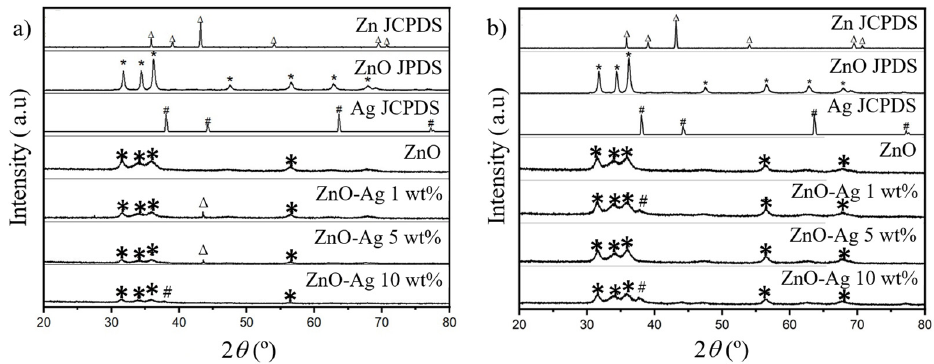
Figure 4. Crystalline phase of ZnO and ZnO ‐ Ag fabricated at a carrier gas (O 2 :N 2 ) ratio of ( a ) 0:1 and ( b ) 1:0. (symbols correspond to ∆ Zn, * ZnO, and # Ag)